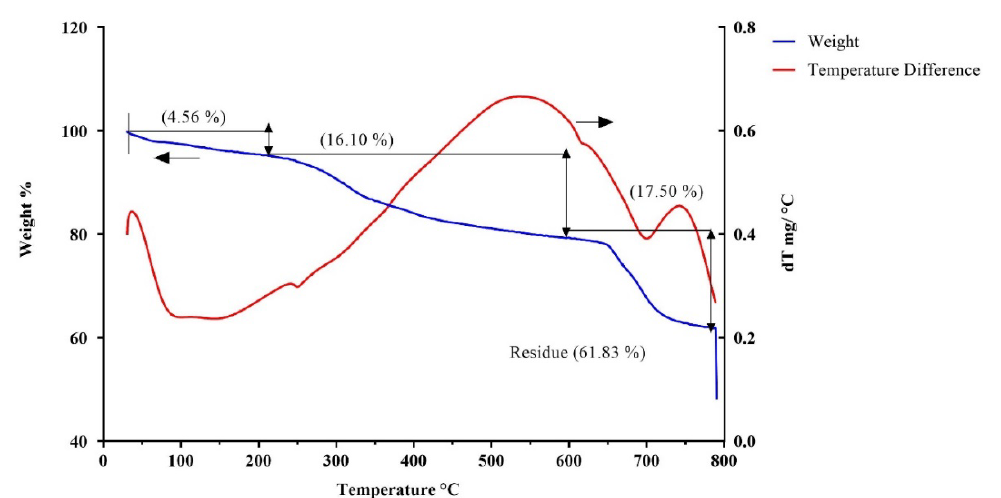
Figure 6. TGA/DTA—thermogram of Virgibacillus dokdonensis VITP14 exopolysaccharide (EPS) with three-stage decomposition. Initial temperature of 28 °C to final temperature of 800 °C.